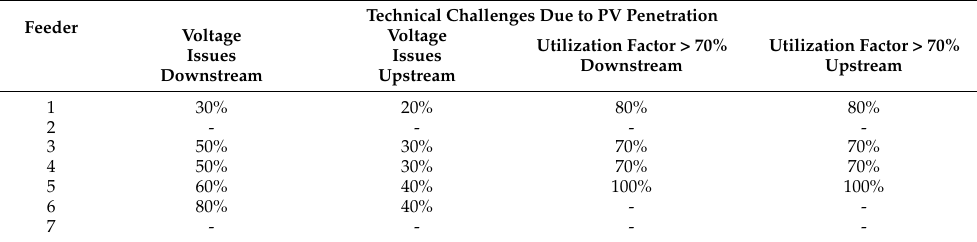
Table 3. Summary of penetration levels and technical challenge thresholds.